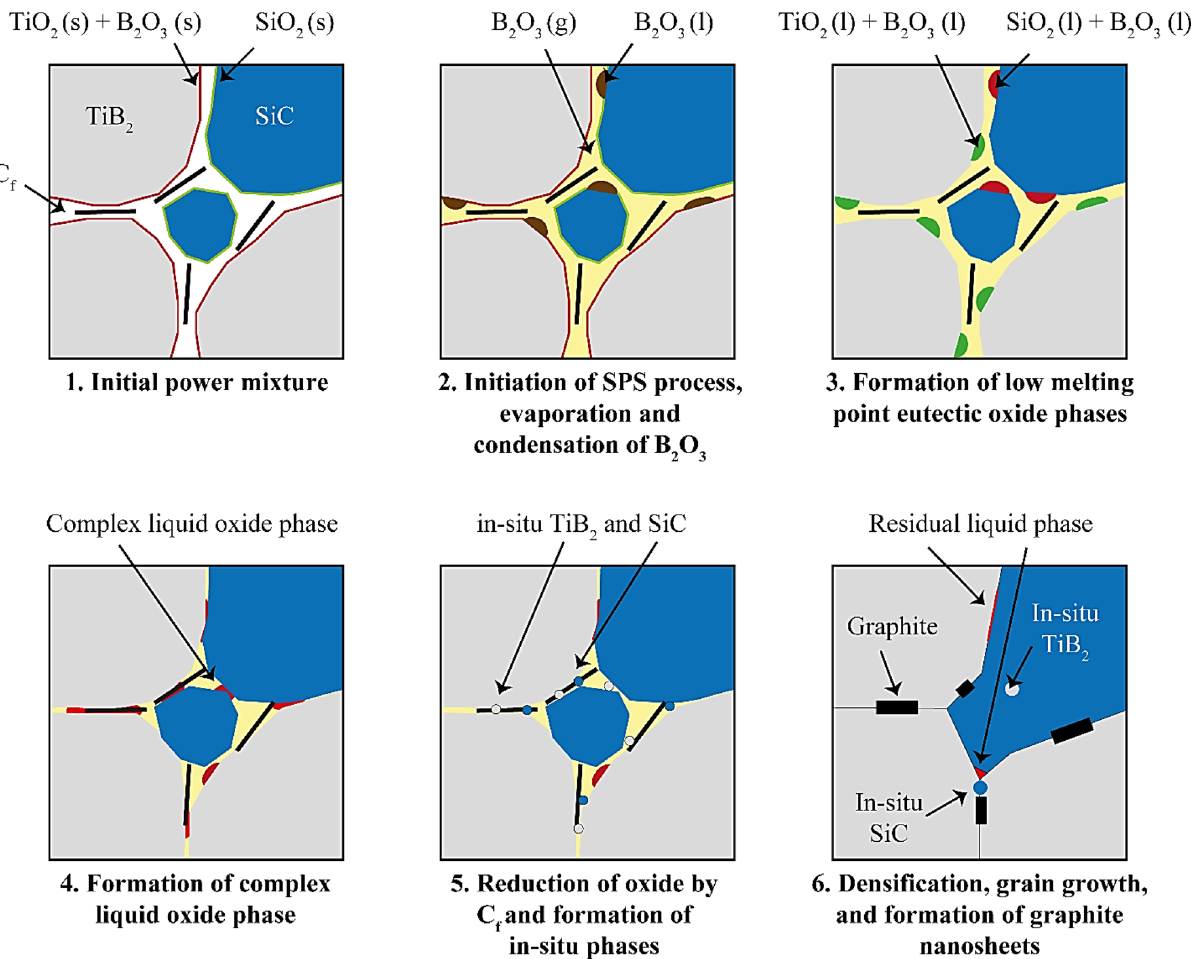
Figure 6. Schematic of steps for the sintering of C f -incorporated TiB 2 –SiC composite, which results in the final